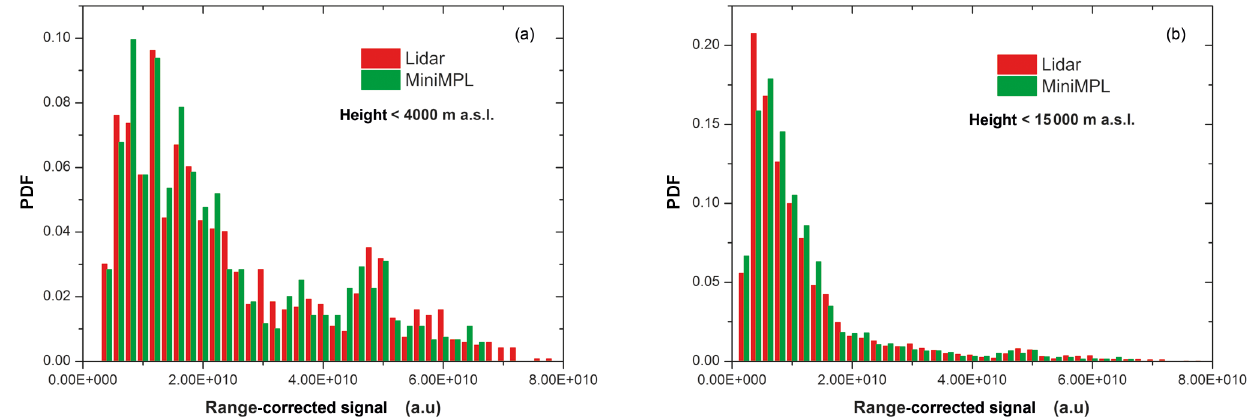
Figure 6. (a) Probability density functions (PDFs) of the RCS values measured by CIAO lidars and MiniMPL below 4km. (b) Same as (a) but for the entire vertical range of observed lidar profiles, below 15km.